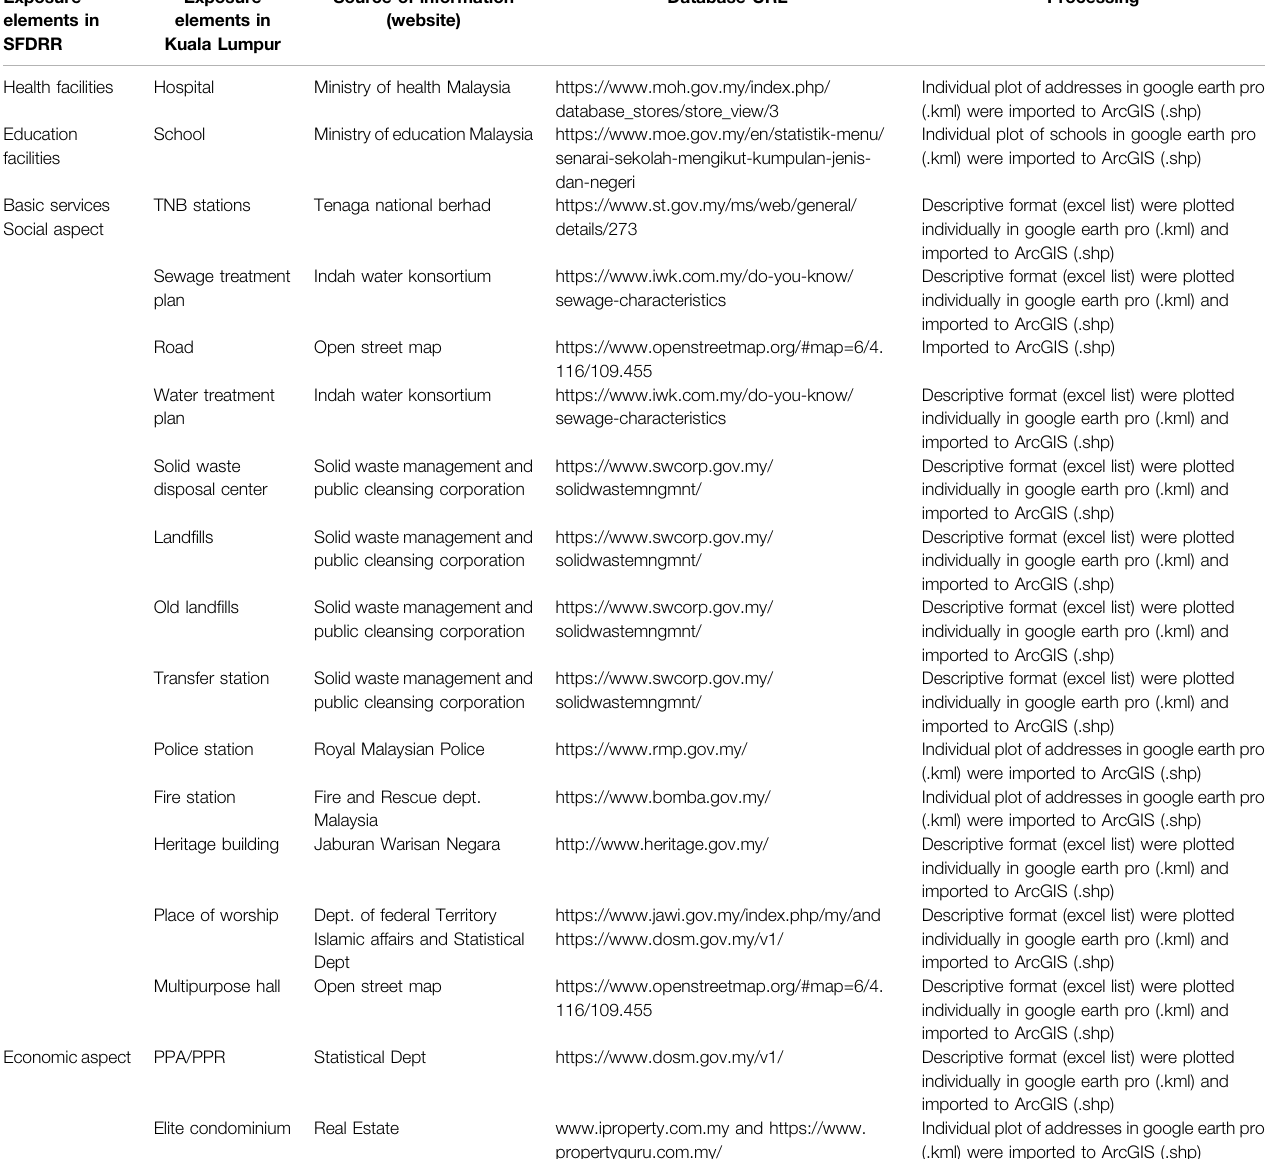
TABLE 3 | Local open-sources of information on exposure elements in Kuala Lumpur. Exposure elements